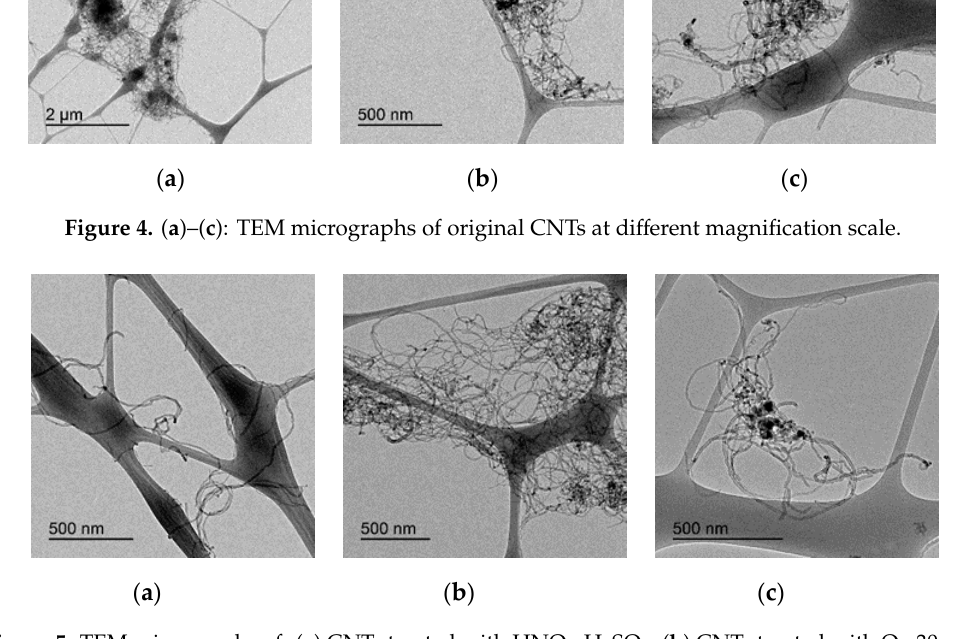
Figure 5. TEM micrographs of: ( a ) CNTs treated with HNO 3 -H 2 SO 4 ; ( b ) CNTs treated with O 3 -30min and ( c ) CNTs treated with O 3 -NaOH.